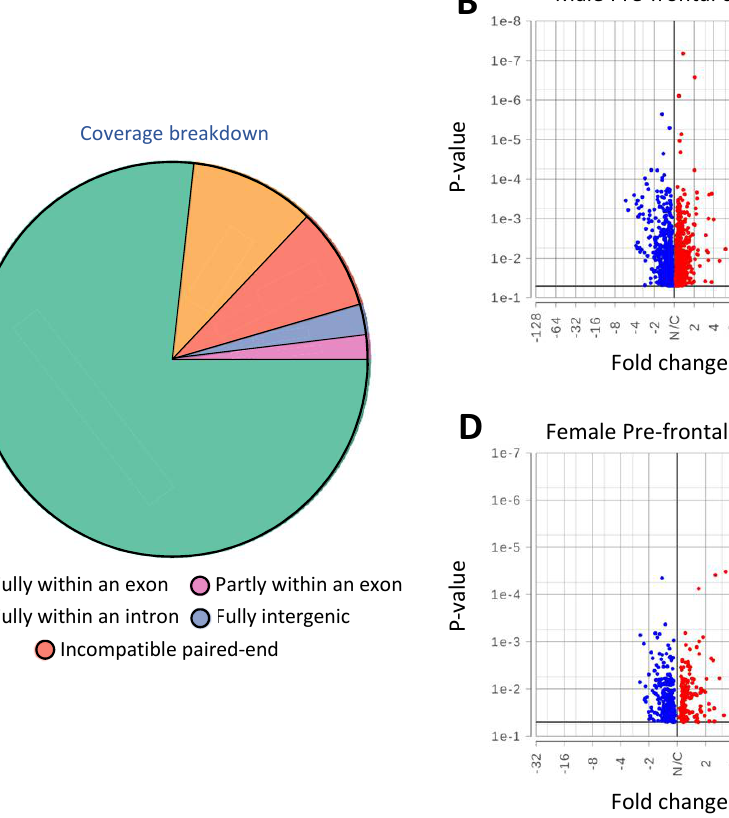
Figure 3. Pre-frontal cortex and hippocampus gene expression profile in Ala92-Dio2 male and female mice. ( A ) RNA-seq coverage breakdown; distribution reflects the average of all samples; ( B ) Pre- frontal cortex differential gene expression (Volcano plot) in Ala92-Dio2 male vs. Thr92-Dio2 male; each point represents the average of 4 mice for each transcript; shown in red are upregulated genes with p < 0.05; shown in blue are downregulated genes with p < 0.05; n = 4–6/group ( C ) Same as A, except that shown is male hippocampus; ( D ) Same as A, except that shown, is the female prefrontal cortex; ( E ) Same as A, except that shown is the female hippocampus. The statistical analysis was done using one-way